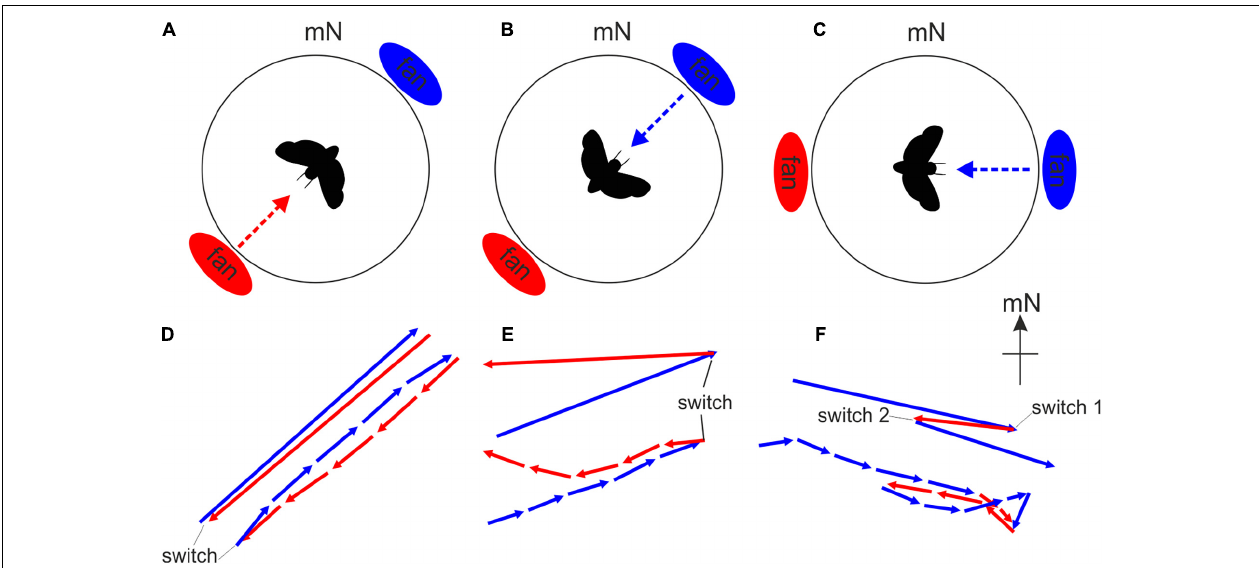
FIGURE 7 | The modified Mouritsen-Frost flight simulator can be used to monitor changes in flight behavior in response to changes in putative orientation cues. Since wind speed and direction influence the migratory behavior of moths (e.g., Chapman et al., 2008b), we exposed migratory Bogong moths to very weak air streams (6 kph) from two different directions relative to magnetic North while they performed flight behavior in our arena. The air streams were generated by two small fans. (A,D) The AB stimulation sequence. The fan located in the southwest was activated ( red dashed arrow ) and the animal flew for 5 min (condition A). We found that moths fly roughly toward the direction of the wind stimulus (i.e., into the wind), as seen by the red flight trajectory vector shown in D . The upper vectors in panels D–F indicate the entire average 5 min flight while the lower vector sequence indicates the flight behavior within each successive 1-min bin. The length of each vector indicates the “directedness” of the flight, that is, the fidelity with which the moth kept to the same flight direction. Directly following condition A, the fan located in the northeast was switched on and the animal flew for another 5 min (condition B), again into the wind as seen by the blue flight trajectory vector shown in D . (B,E) The BA stimulation sequence. The same procedure as in A,D but with the wind stimulus presented in the reverse sequence. (C,F) The ABA stimulation sequence. Here the fans were rotated by 45 ◦ to form an east-west axis. The fan located in the east was activated first ( blue dashed arrow ) and the animal flew for 5 min (condition A). Then the fan located in the west was activated for 5 min (condition B). Finally condition A (east fan activated for 5 min) was